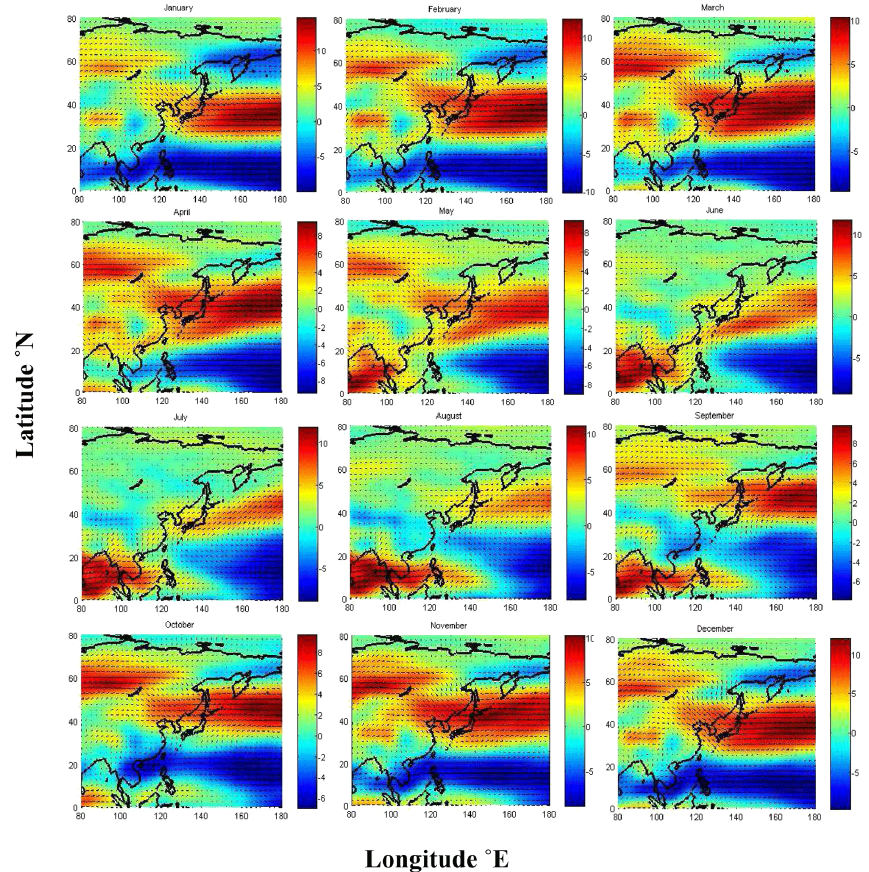
Figure 2. NCEP/NCAR reanalysis of the mean synoptic wind vector (ms − 1 ) at 850mb pressure level for each month over the study area during